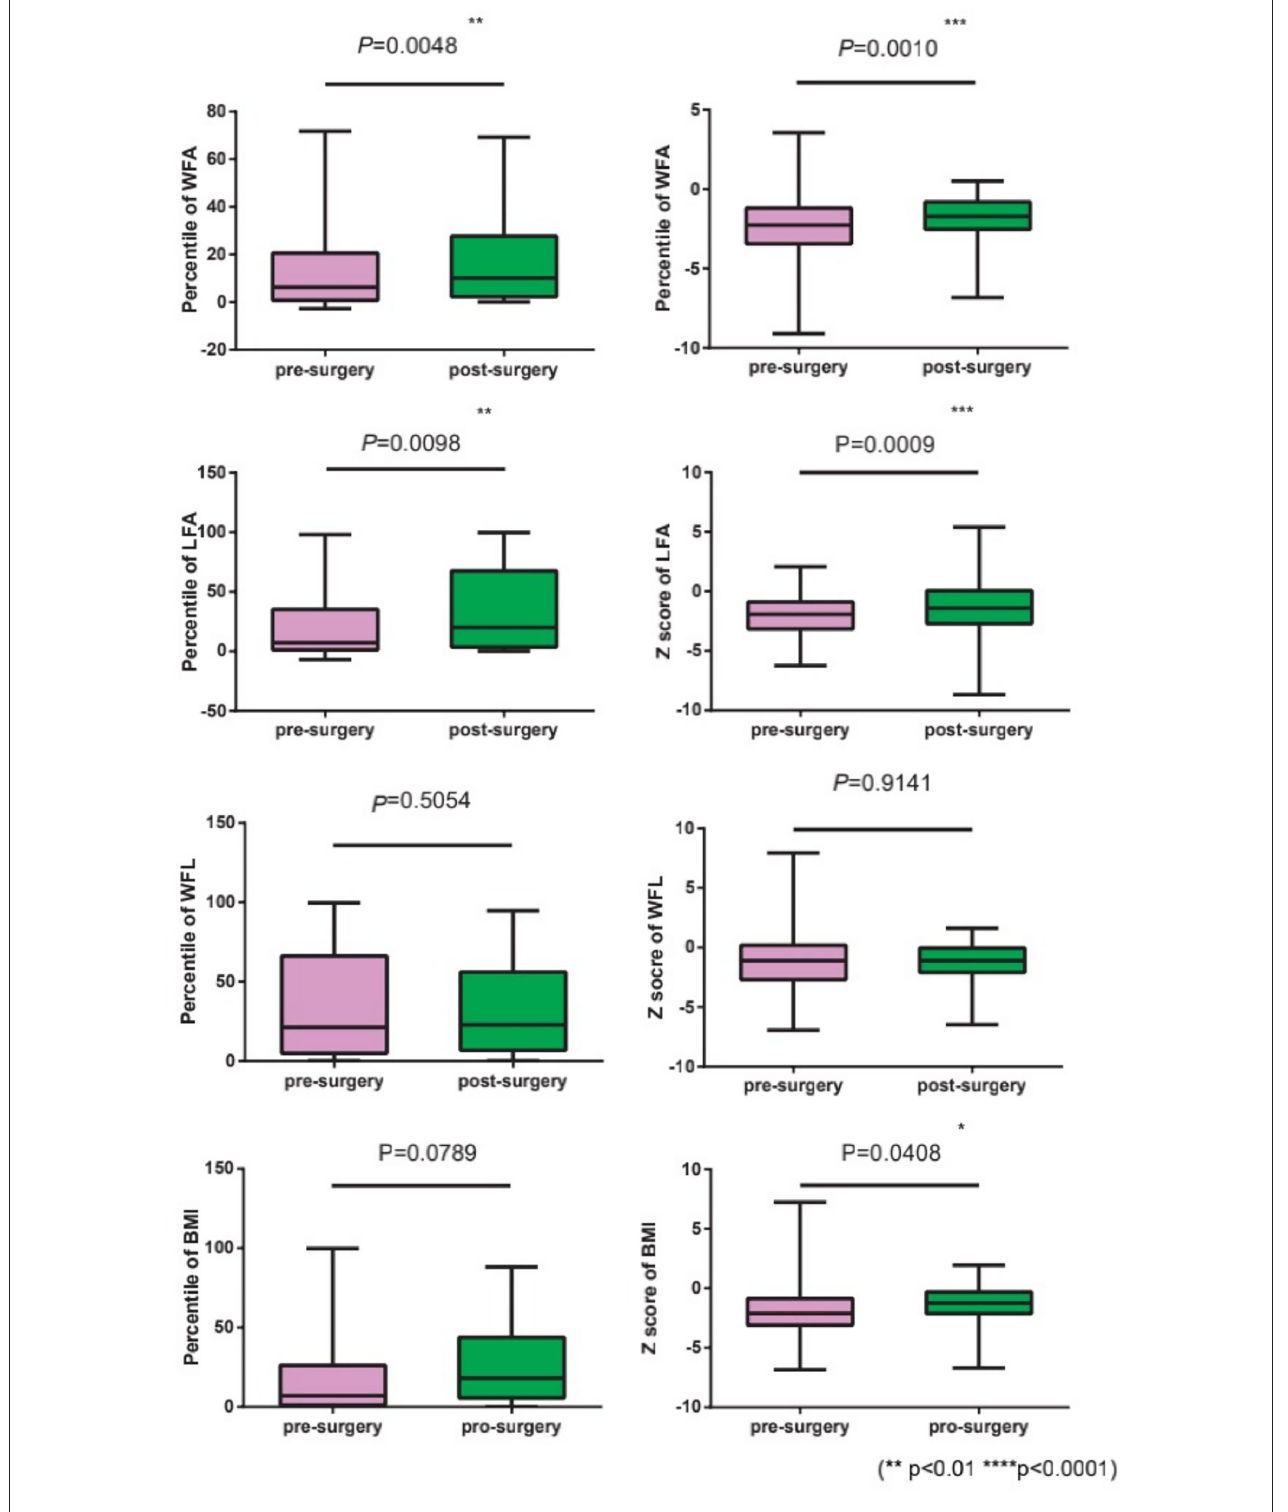
FIGURE 1 | Independent sample comparison statistics of pre- and post-operative body index. * P < 0.05, *** P < 0.001.